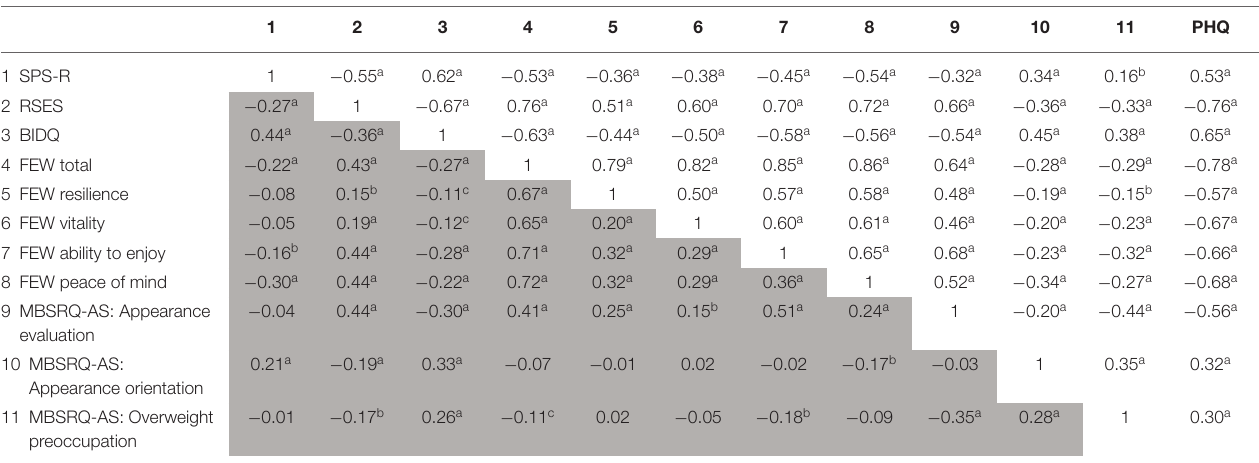
TABLE 4 | Associations between skin picking severity, self-esteem, body image, and physical